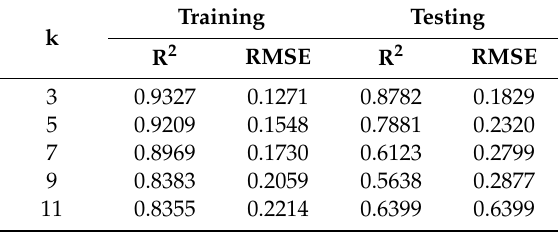
Table 12. Statistical results of drying kinetics of persimmon samples for k nearest neighbors (kNN) model using VD method. Training Testing k R 2 RMSE R 2